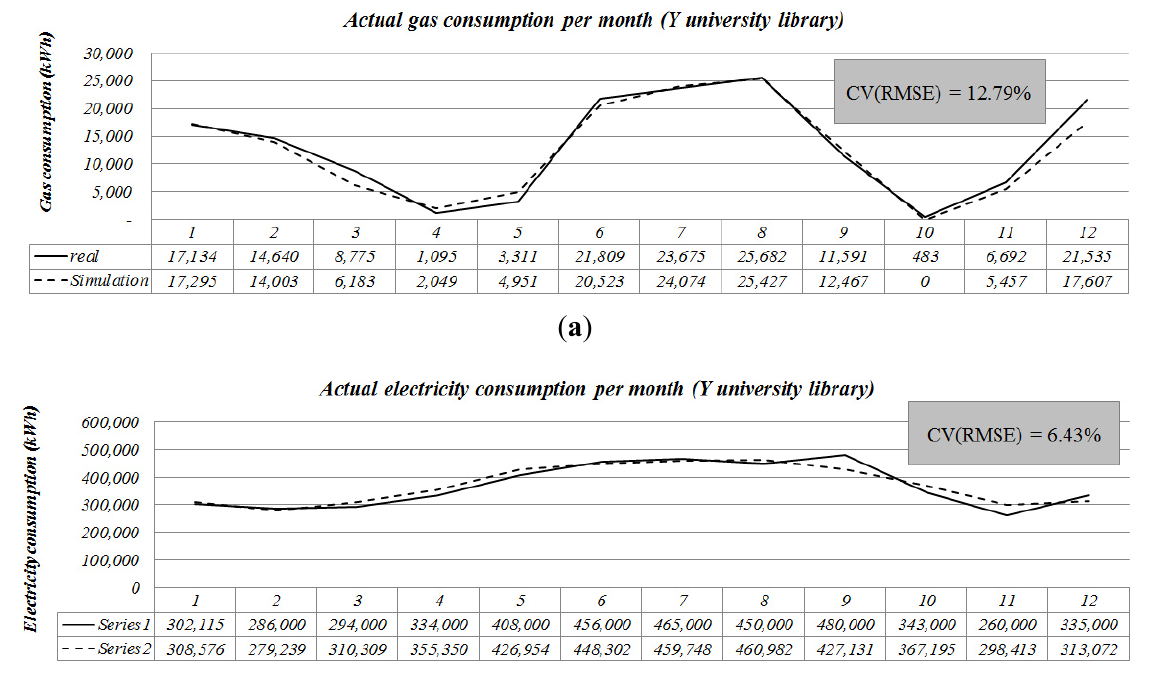
Figure 5. (CV)RMSE: ( a ) Gas consumption (“Y” university library); ( b ) Electricity consumption (“Y” university